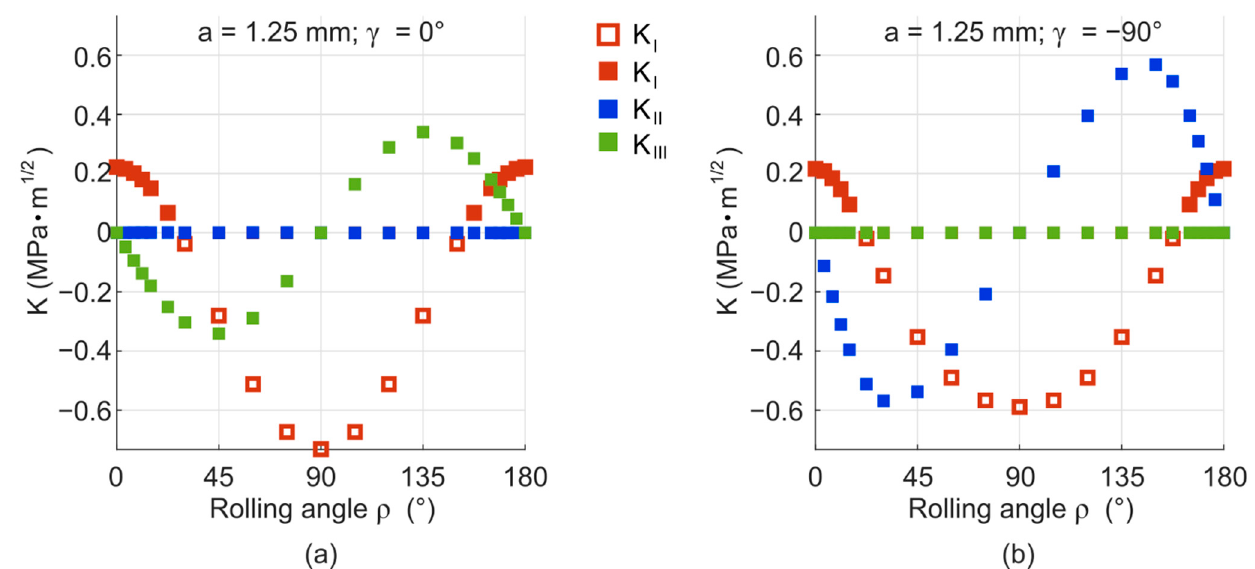
Figure A5. Course of stress intensity factors during rotation in the cylinder D × L = 6 × 6 mm 2 , load F = 350 N, a = 1.25 mm, position on the crack front; ( a ) γ = 0°; ( b ) γ = − 90°.